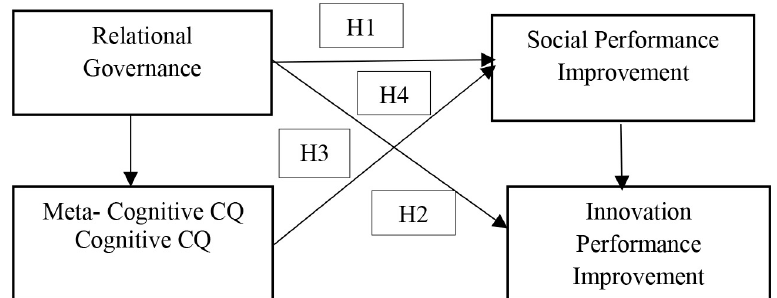
Figure 1. Conceptual